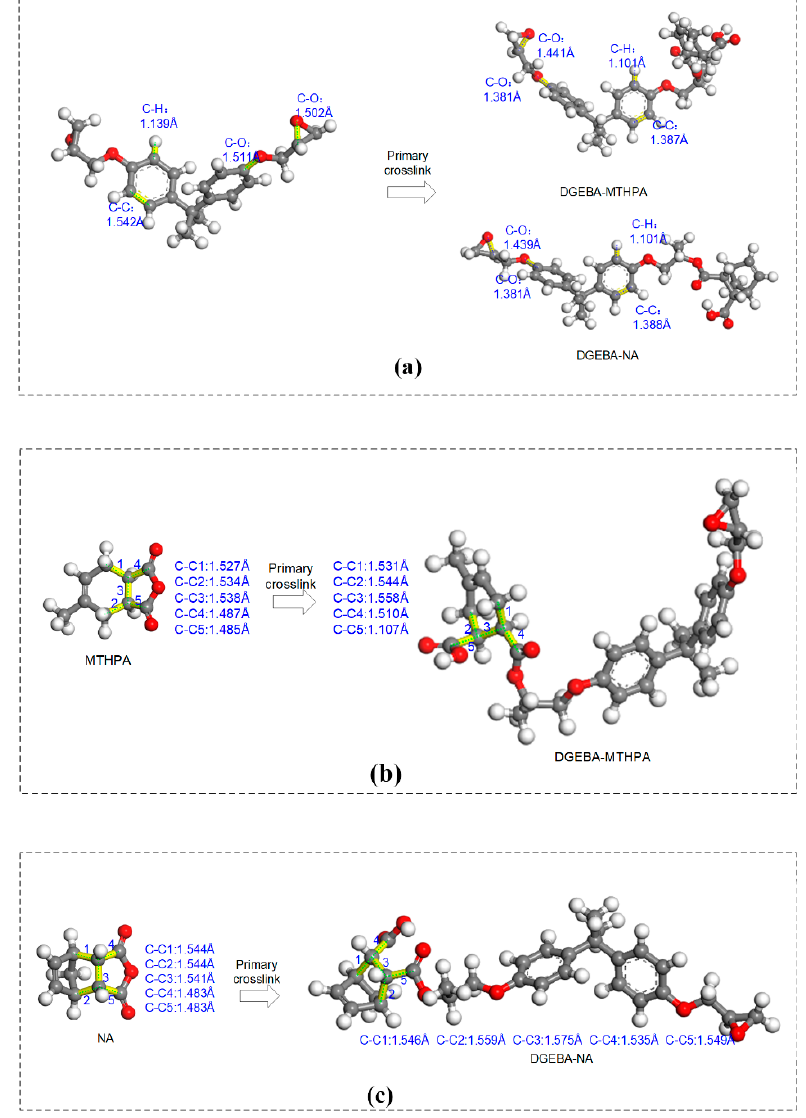
Figure 5. Specific bond length changes between the monomers and primary crosslinking structures. ( a ) The primary crosslinking structure and the epoxy resin DGEBA; ( b ) the primary crosslinking structure and the curing agent MTHPA; ( c ) the primary crosslinking structure and the curing agent NA.